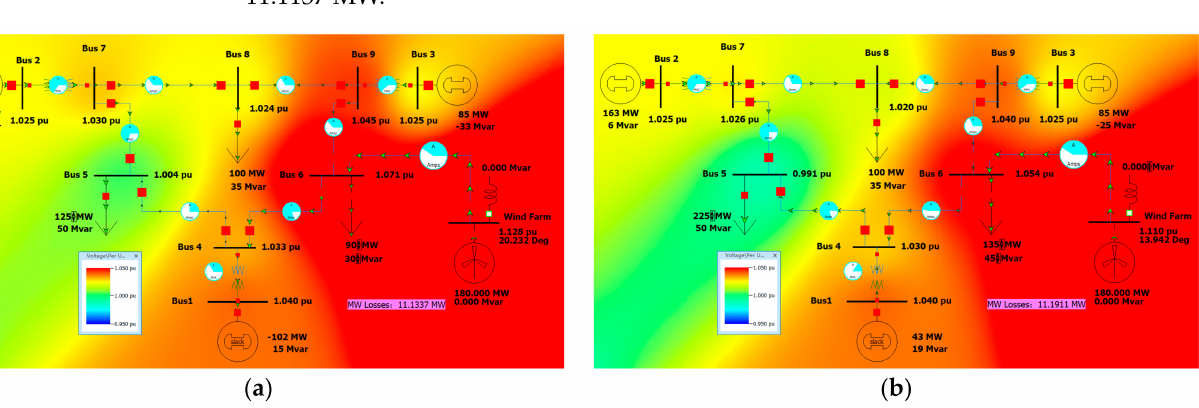
Figure 4. Simulation results with Tower A connected to bus 6 (300 km). ( a ) The results under the minimum load condition and ( b ) the results under the maximum load